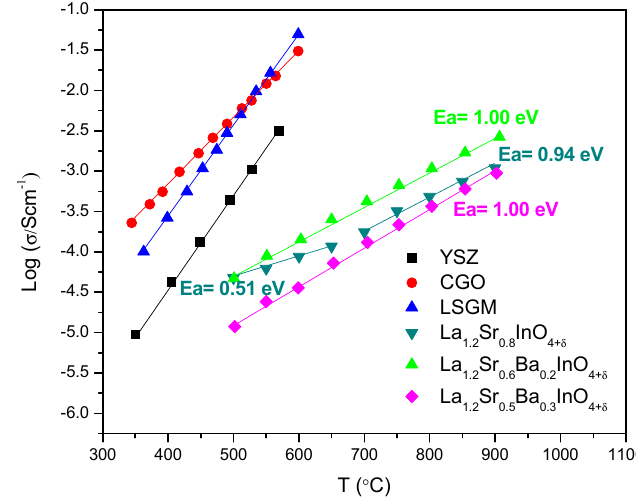
Figure 5. Conductivity for different electrolytes compared to La 1.2 Sr 0.8 − x Ba x InO 4+d Reference [23]. In other words, the layered perovskite of La 1.2 Sr 0.6 Ba 0.2 InO 4.10 is among the few oxides containing